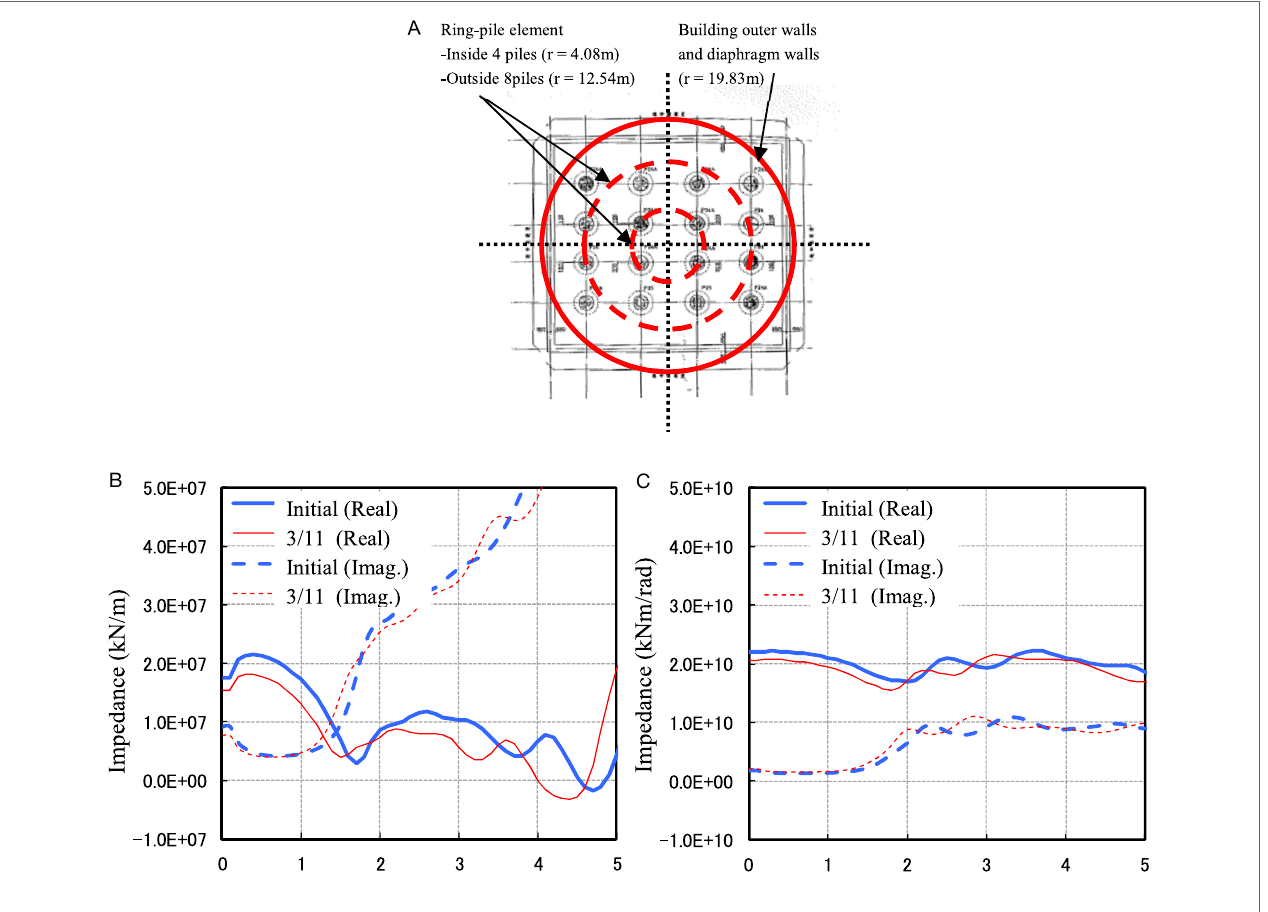
FigUre 5 | Modeling of underground part. (a) Schematic diagram of the model used for axisymmetric analysis, (B) calculated sway impedance, and (c) rocking impedance.